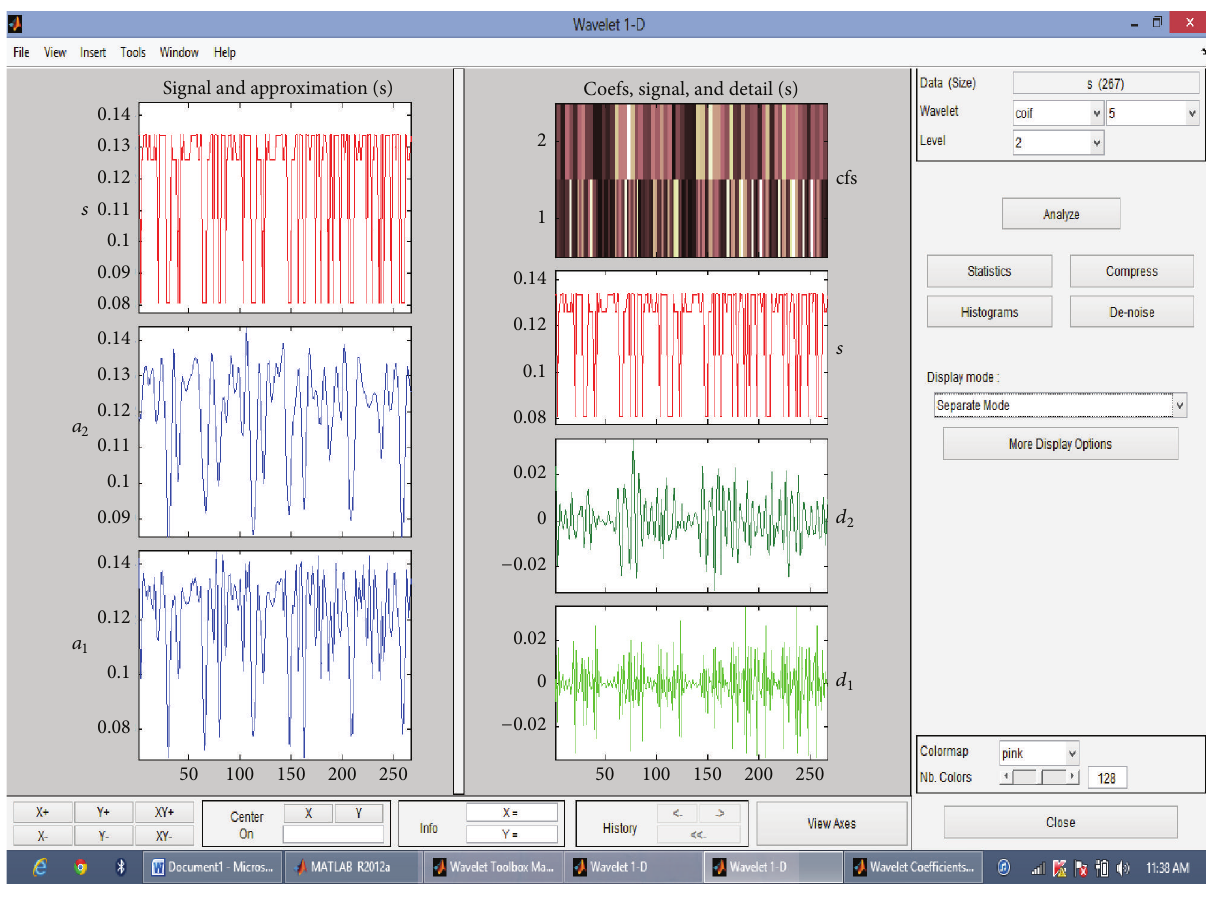
Figure 2: Approximate and detail coefficients for Coiflet 5 (level 2) using wavelet tool